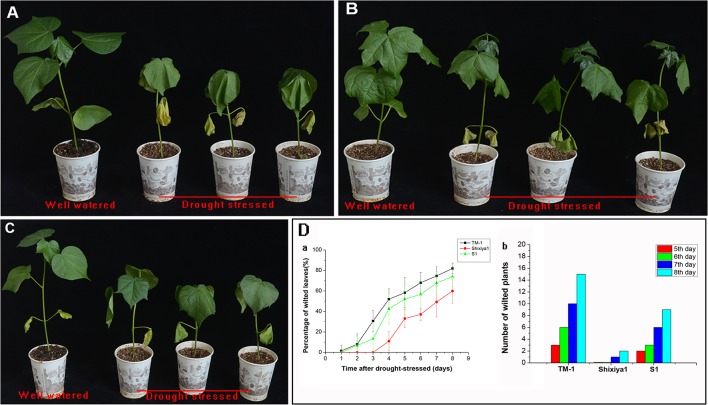
Phenotypes of 8-day drought treatment and percentage of leaves wilted and wilted plants after drought stress.A, TM-1; B, Shixiya 1; C, S1; D-a, Percentage of wilted leaves after drought-stressed; D-b, Number of wilted plants after drought-stressed.